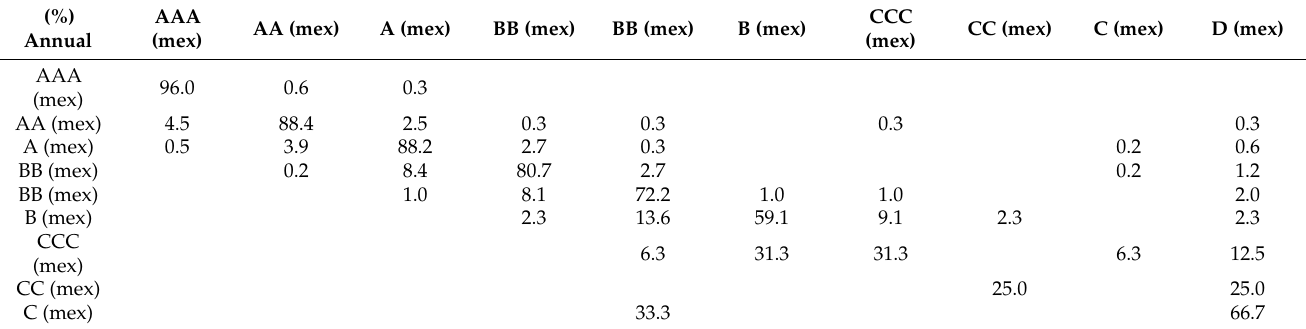
Table 1. Mexico Corporate Finance National Ratings Transition